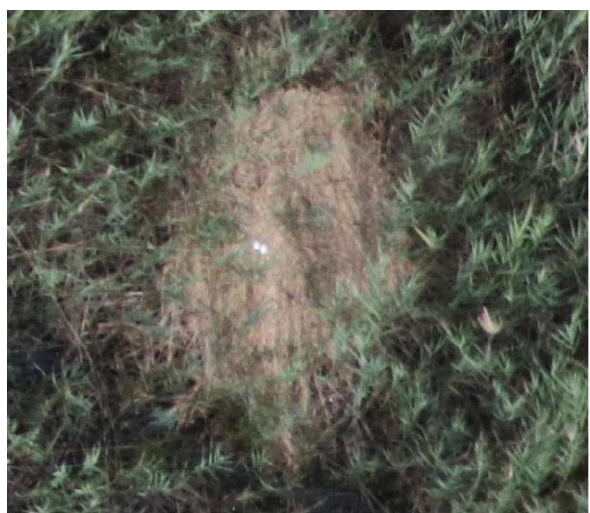
Figure 9. Nest with eggs. Isolated nest with eggs—details of an orthophoto with 0.7 cm spatial resolution.